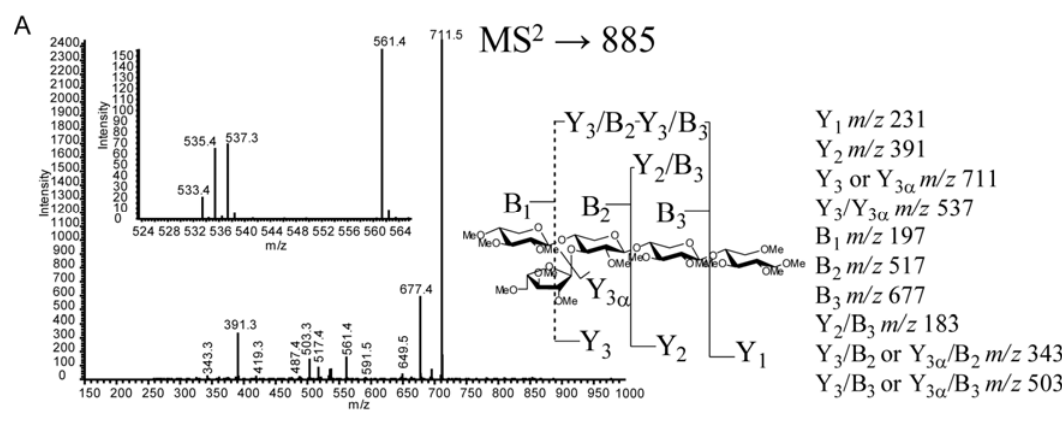
Figure 6. MS n fragmentation of permethylated oligosaccharide VIII (RT 28.5 min) ( a ) MS 2 m/z 885. ( b ) MS 3 fragmentation m/z 885 → 711. ( c ) MS 4 fragmentation m/z 885 → 711 →